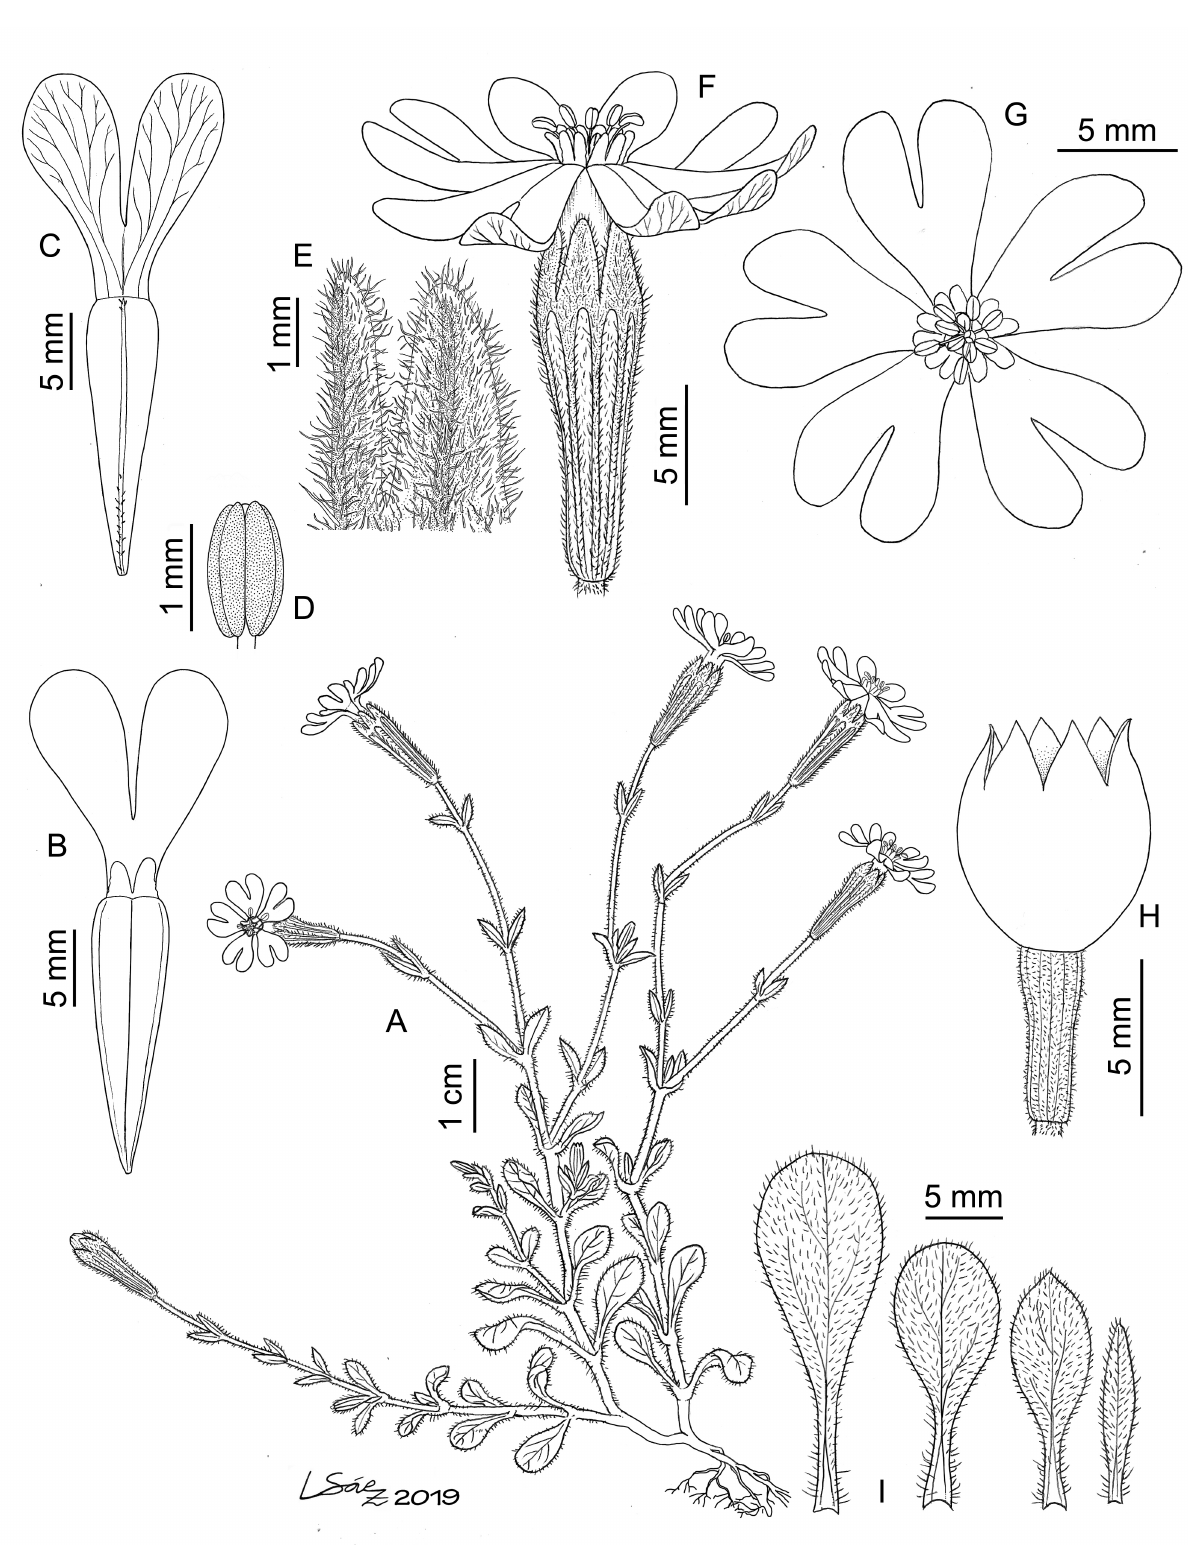
Figure 1. Silene migjornensis . A: Habit. Flower (lateral view). B: Petal (ventral view). C: Petal (dorsal view). D: Anther; E: Calyx teeth. F: Flower (lateral view). G: Flower (above view). H. Capsule. I: Leaves. Illustration by L. Sáez based on living material from Mallorca, Ses Covetes (L. Sáez, herb. pers., no.